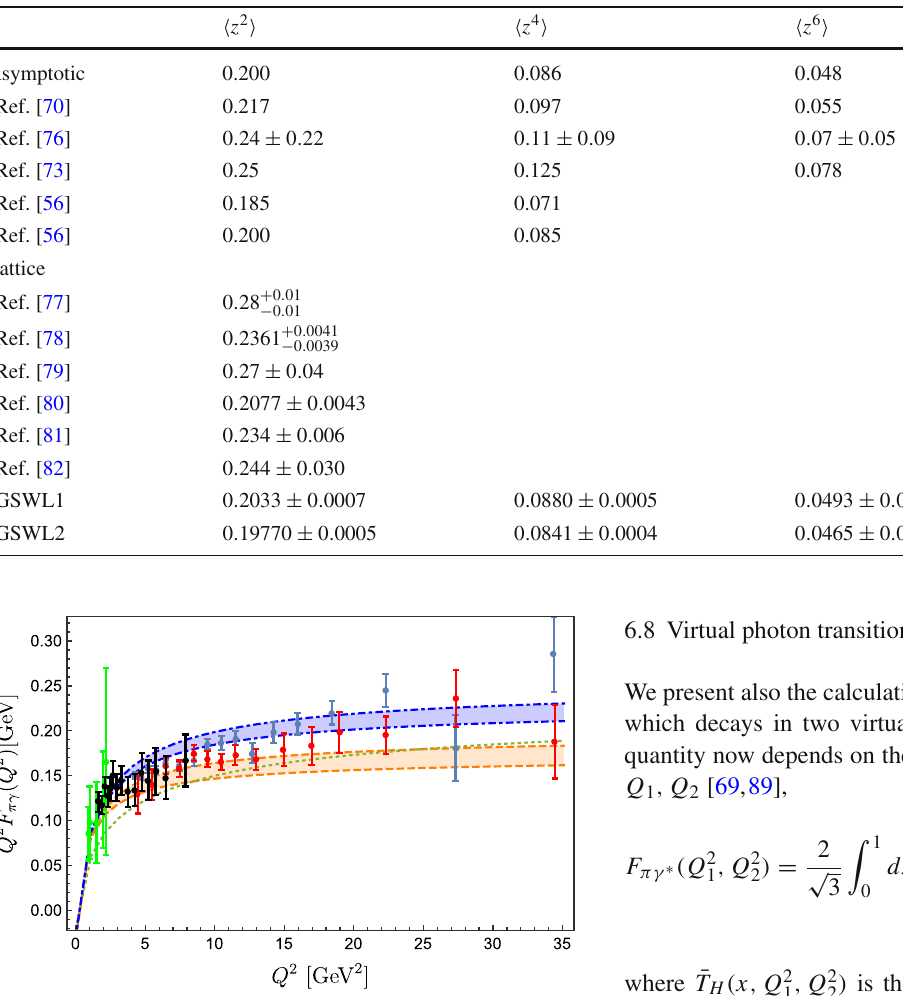
Table 5 Comparison between the moments of the DA evaluated with the GSWL models and other approaches. The error in the GSWL1 and GSWL2 models is due to the uncertainty of the initial scale 0 . 07 ≤ μ 2